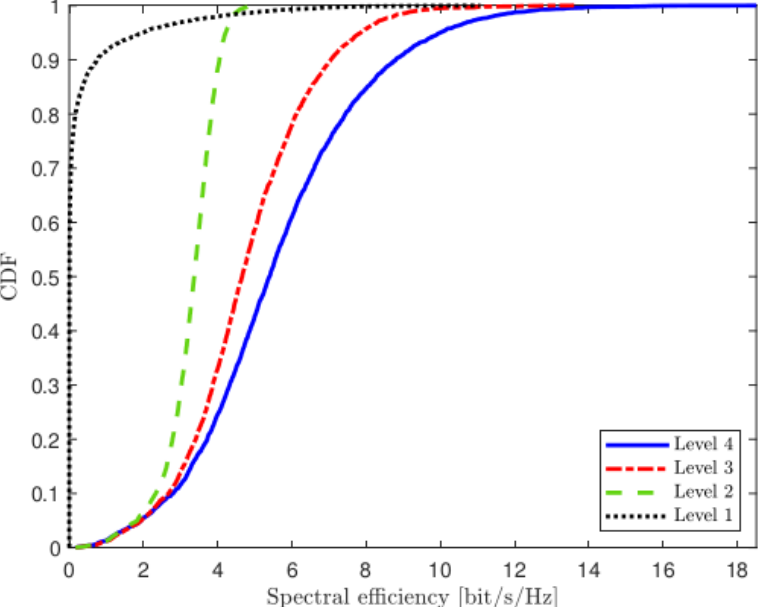
Figure 3. Comparison of CF-M-MIMO with different levels of multiple CPUs cooperation in the case that all APs serve the